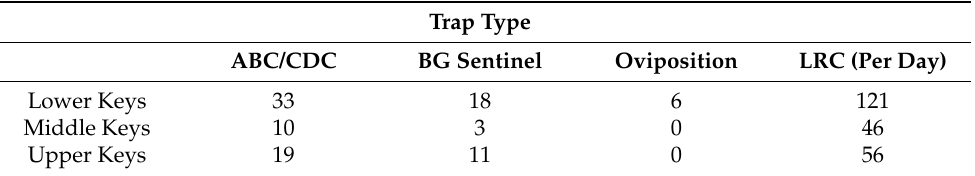
Table 1. Type and number of traps set weekly and Landing Rate Counts (LRC) per day for routine surveillance in 3 FKMCD subdivisions of the Florida Keys, 2021. (ABC, American Biophysics Company; CDC, Centrs for Disease Control; BG, Biogents). Trap Type ABC/CDC BG Sentinel Oviposition LRC (Per Day) Lower Keys 33 18 6 121 Middle Keys 10 3 0 46 Upper Keys 19 11 0